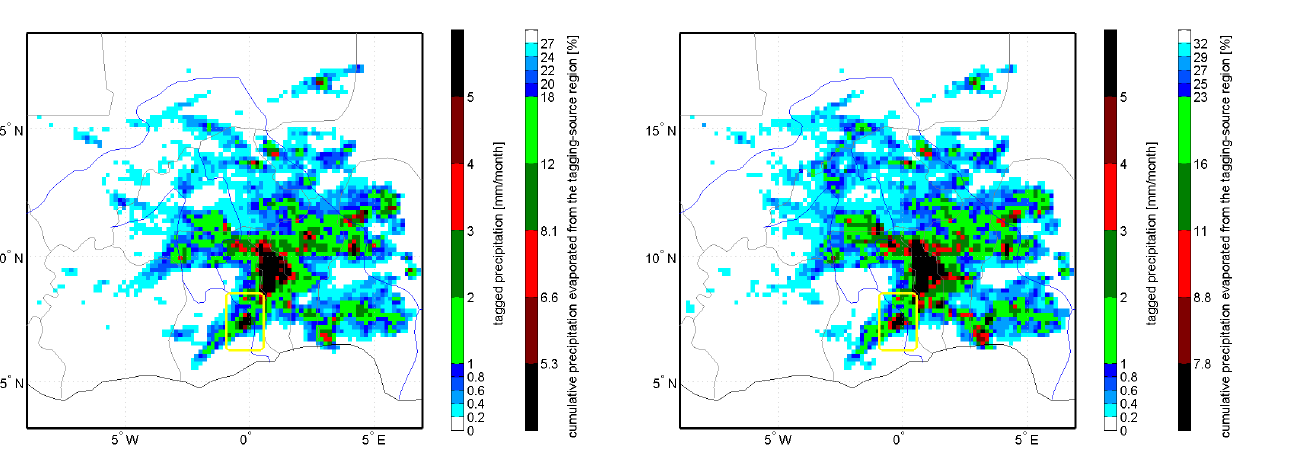
Fig. 8. Precipitation of Volta origin in August 1998 as computed by 3D-T-E_lowmixing-P_fromclouds. See Fig. 3 for an explanation of the